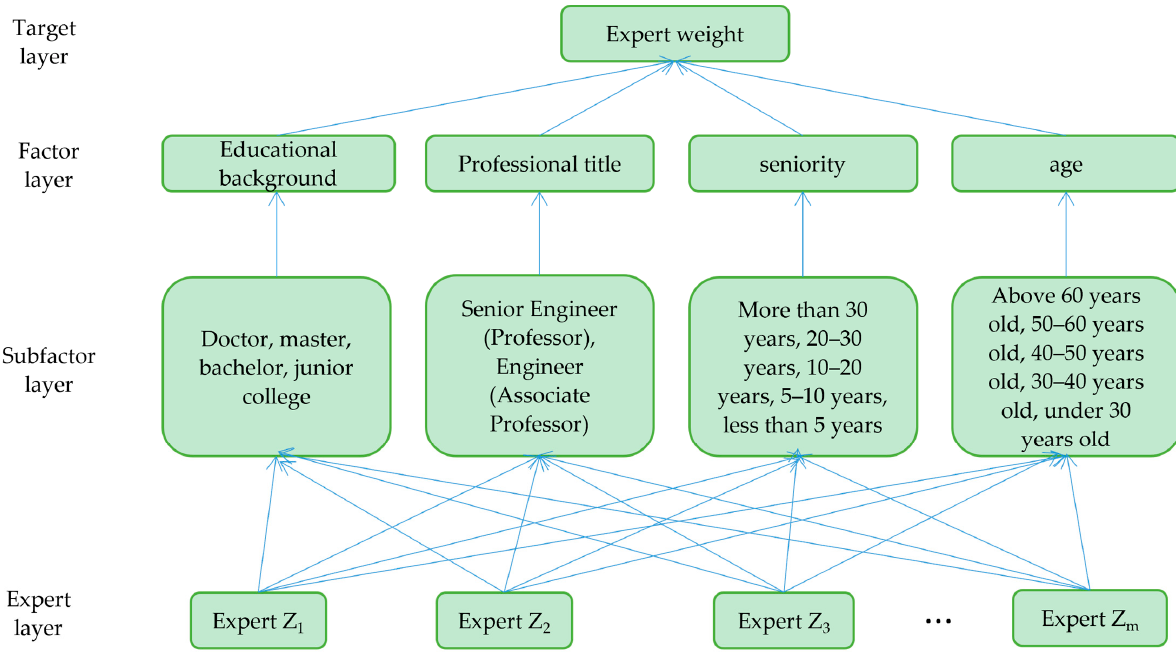
Figure 4. Expert weight hierarchy model.